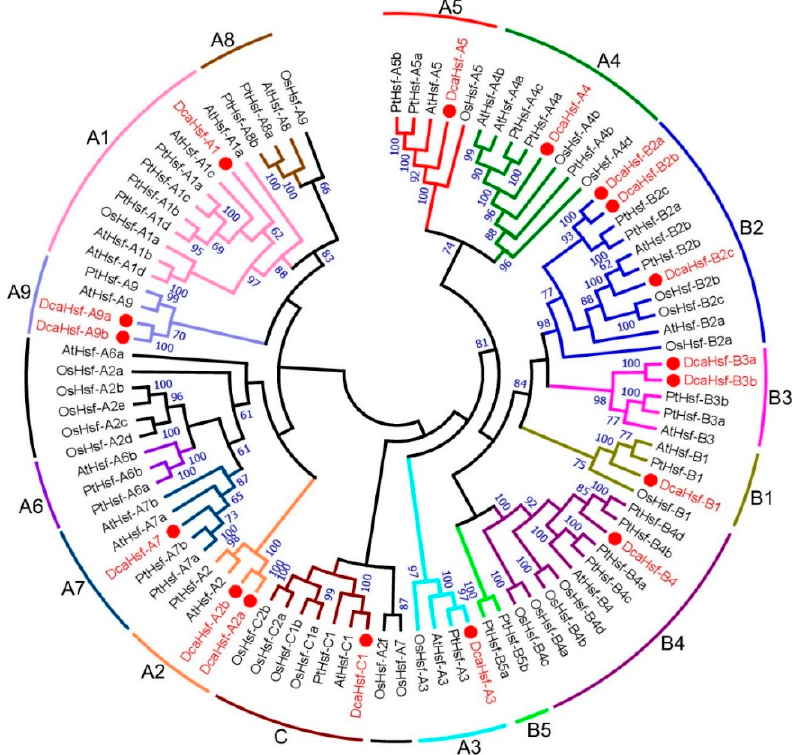
Figure 2. The phylogenetic tree of Hsf proteins. The phylogenetic tree of Hsf proteins in carnation and other plant species was generated by MEGA 7 using the neighbor-joining method. Dca, D. caryophyllus ; At, Arabidopsis thaliana ; Os, Oryza sativa and Pt, Populus trichocarpa